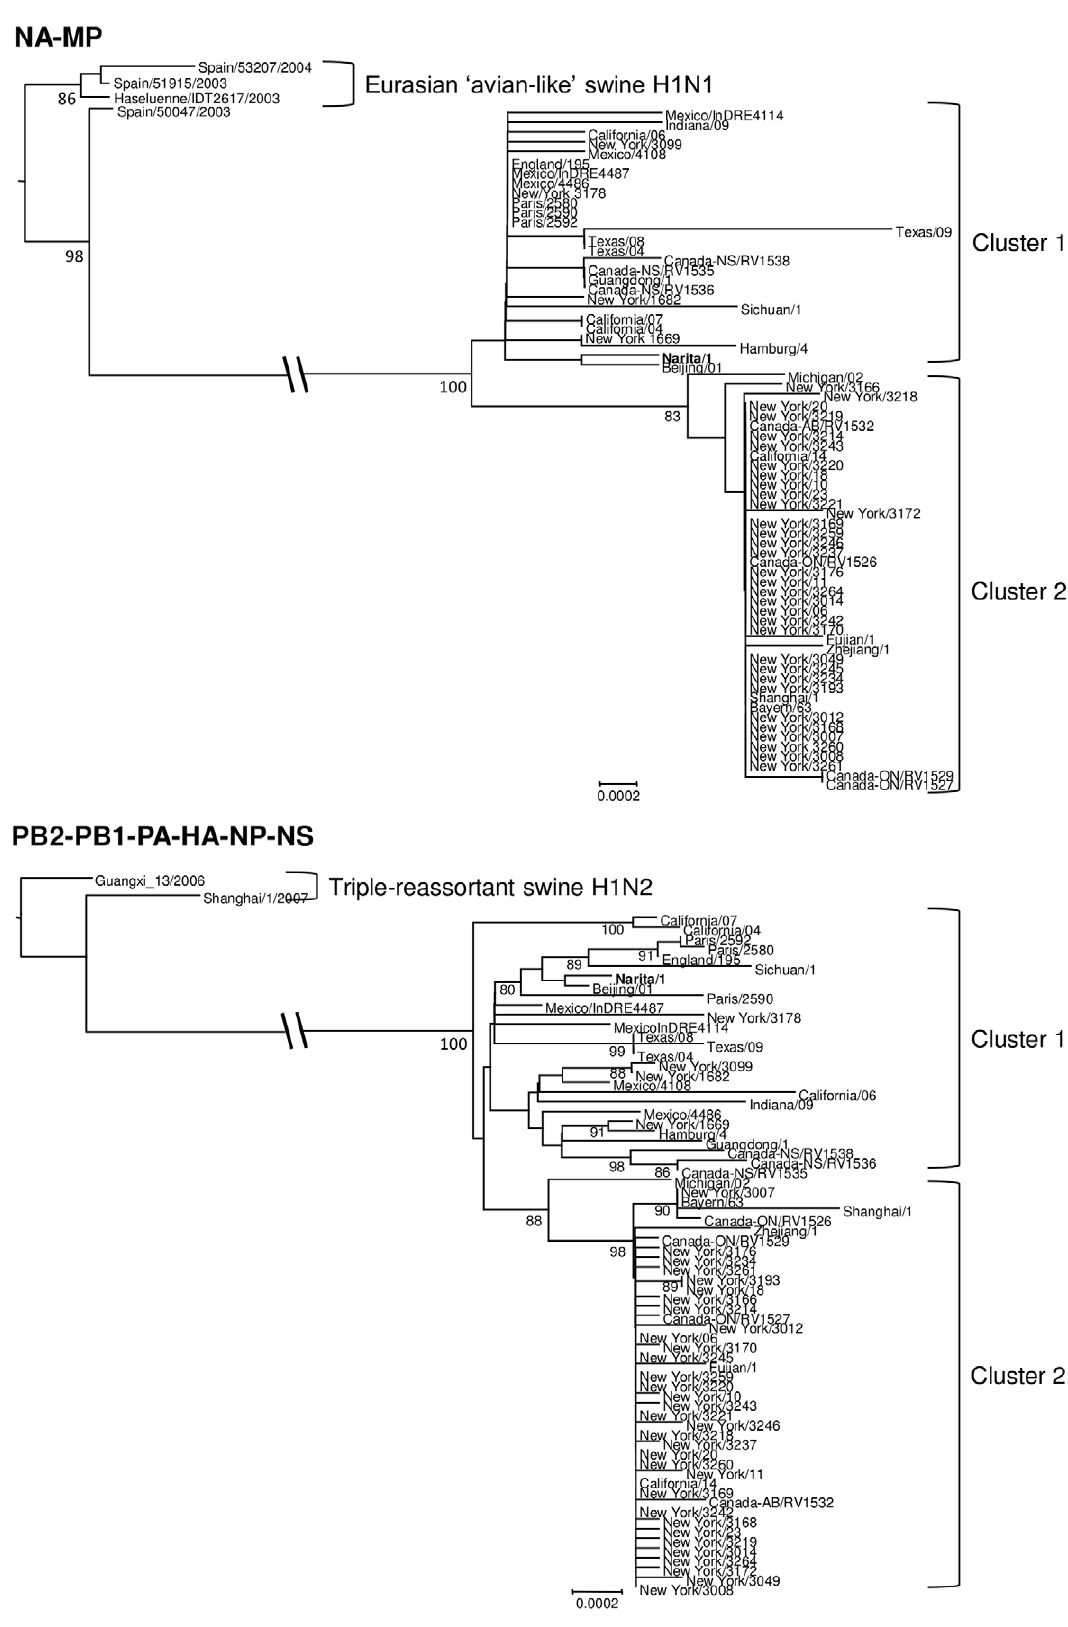
Figure 3. Distance-based neighbor joining phylogeny of influenza A(H1N1)pdm in early phase of the pandemic with particular swine influenza strains. The upper panel shows the phylogeny using NA-MP that was derived from Eurasian avian-like swine H1N1 virus. The